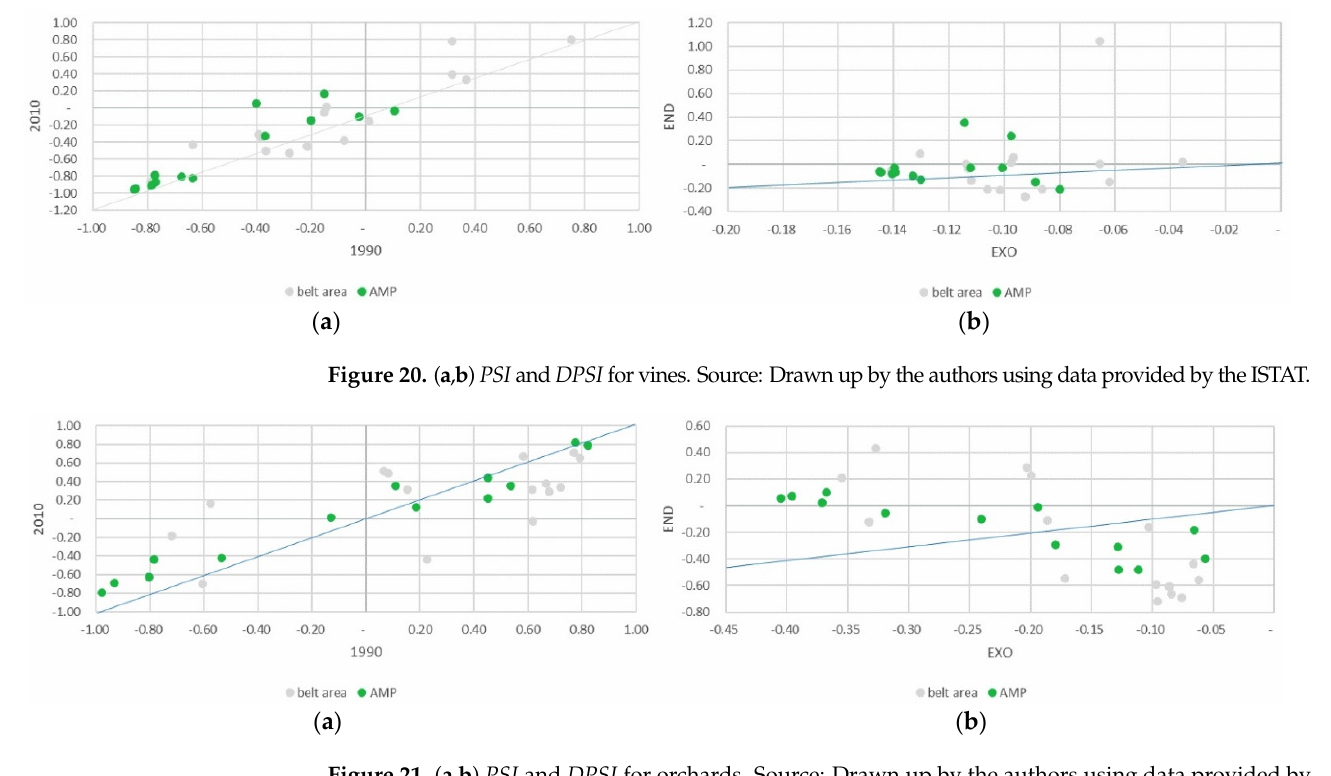
( d ) Figure 19. ( a – d ) PSI and DPSI for Cereals and Olive trees. Source: Drawn up by the authors using data from the ISTAT. Trends in the Specialization in Vineyards (1990–2010)